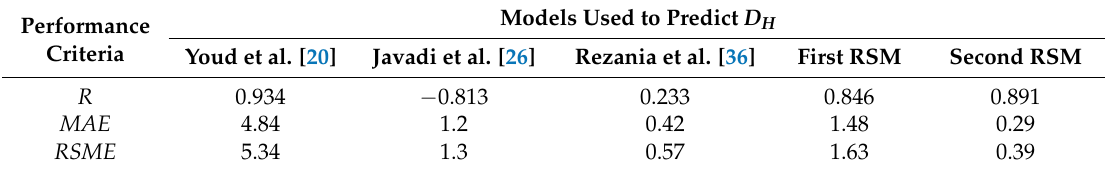
Table 9. Performance certificate of second RSM equation, on the basis of samples with F 15 ≤ 28% in comparison with extra available models.